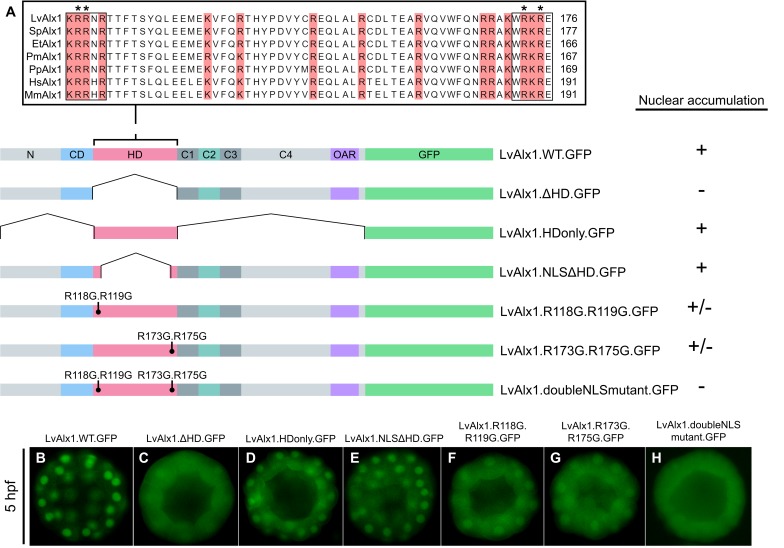
Basic residues flanking the LvAlx1 homeodomain function as nuclear localization signals.(A) Top: Clustal Omega alignment of Alx1 homeodomains from L. variegatus (LvAlx1), S. purpuratus (SpAlx1), E. tribuloides (EtAlx1), P. miniata (PmAlx1), P. parvamensis (PpAlx1), H. sapiens (HsAlx1), and M. musculus (MmAlx1). Boxed sequences indicate the two NLS-like motifs flanking the homeodomain. Asterisks show the NLS residues targeted for mutations. Bottom: LvAlx1 constructs used in nuclear localization studies. (B–H) GFP fluorescence of embryos injected with the different NLS mutants. (B) LvAlx1.WT.GFP shows robust nuclear accumulation throughout development. (C) Removal of the homeodomain (LvAlx1.ΔHD.GFP) causes a diffuse protein distribution. (D) The homeodomain alone (LvAlx1.HDonly.GFP) is sufficient to drive nuclear accumulation. (E) Retaining only the two NLS motifs from the homeodomain (LvAlx1.NLSΔHD.GFP) allows the protein to accumulate in the nucleus. (F and G) Mutation of either of the NLS motifs result in weaker nuclear accumulation. (H) Mutation of both NLS motifs result in completely diffused protein distribution.